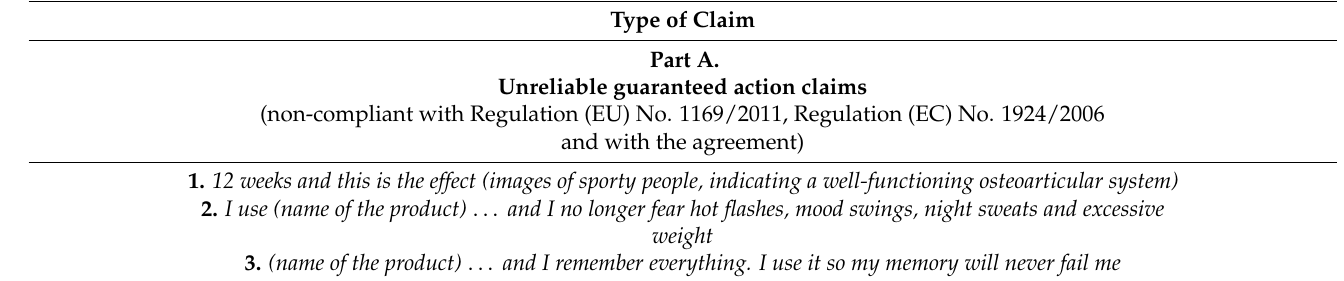
Table 2. Action of the advertised supplements or their ingredients. ACTION OF DIETARY SUPPLEMENTS ACCORDING TO